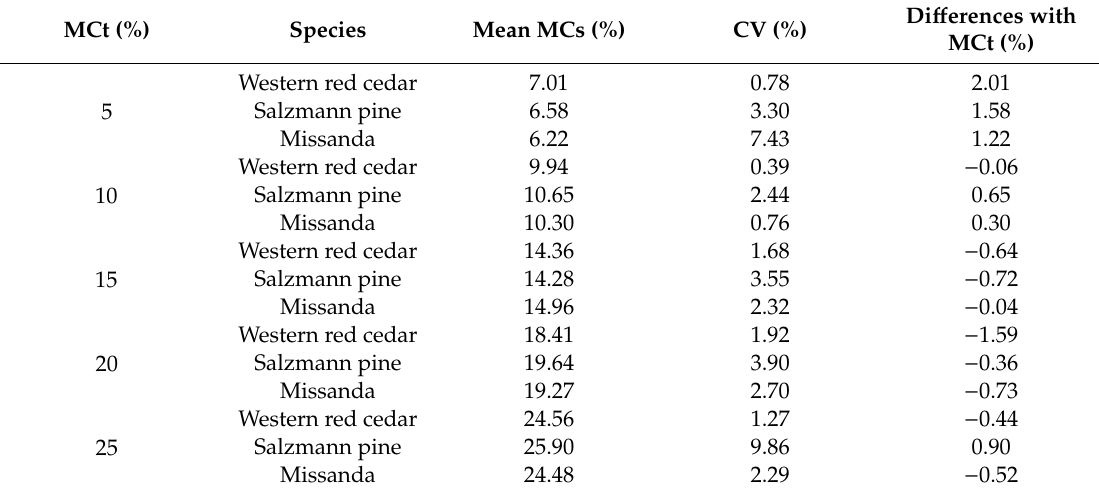
Table 3. Average values and coefficients of variation (CV) of MCs of the specimens stabilized to different target moisture contents (MCt).